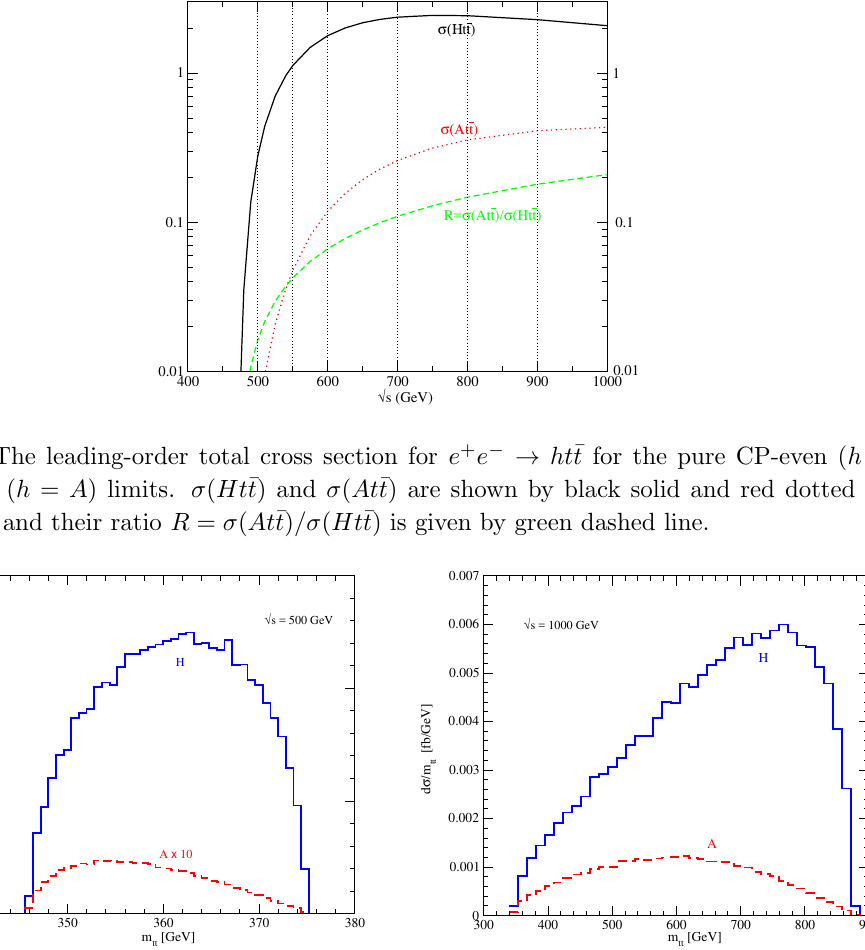
Figure 6 . m t (cid:22) t distributions for H and A at p s = 500 GeV (left) and 1000 GeV (right) in the leading